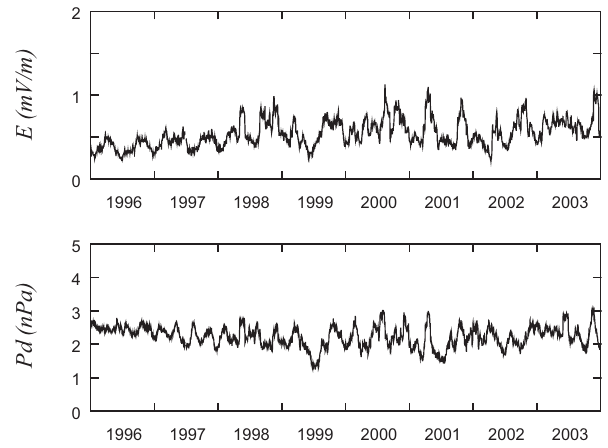
Fig. 5. Long-term variations (30-day averages) of the solar-wind electric field (top panel) and the solar-wind dynamic pressure (bot- tom panel) from 1996 to